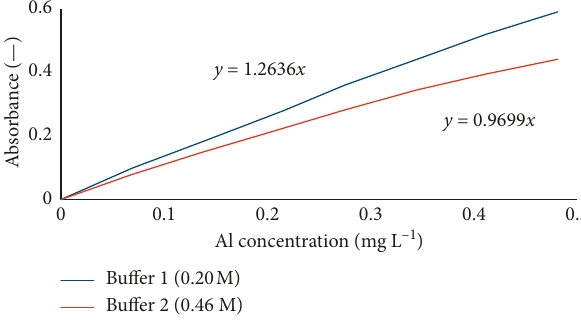
Figure 4: The effect of acid concentration on absorbance.